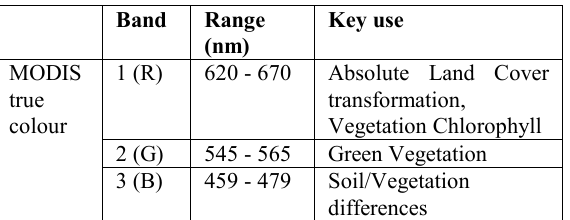
Figure 5. Cloud free MODIS image mosaic of Sri Lanka.